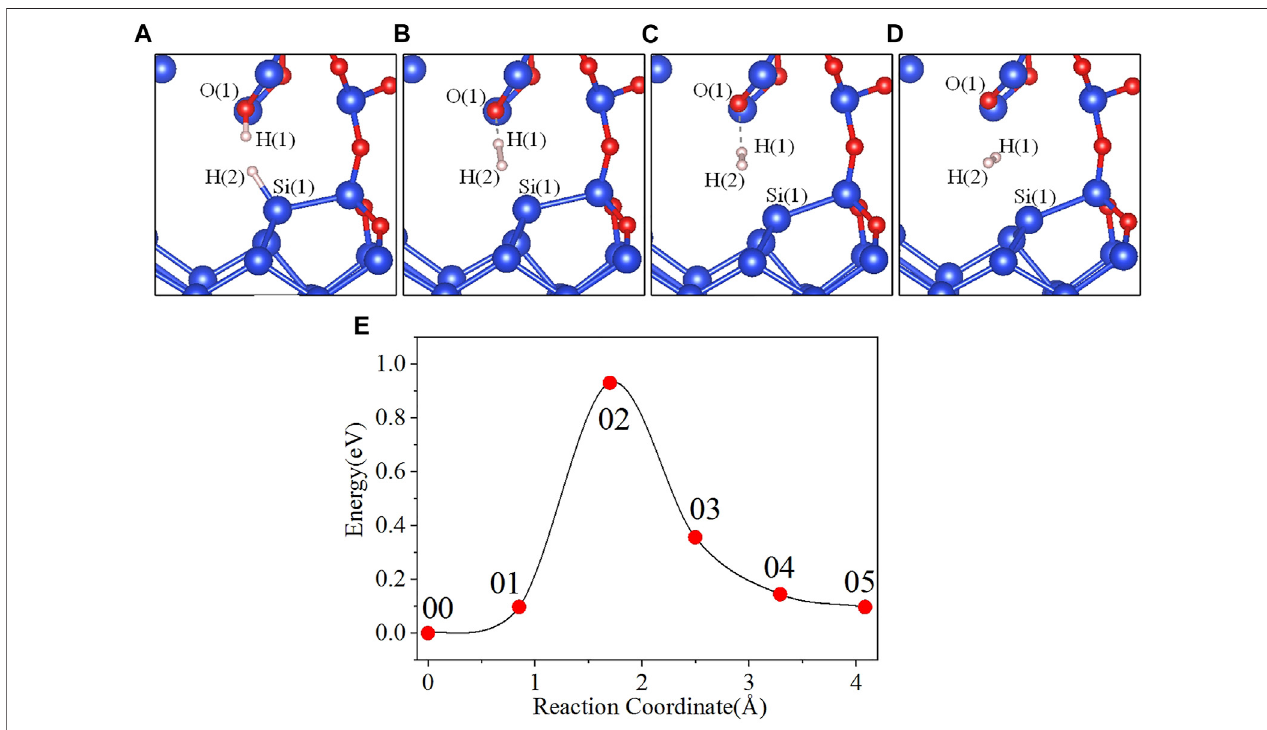
FIGURE4| Intermediatestatesandenergypro fi lecurveofthe P b1 defectdepassivationreaction. (A) 01state, (B) 02state, (C) 03state, (D) 04stateand (E) energy pro fi le curve.